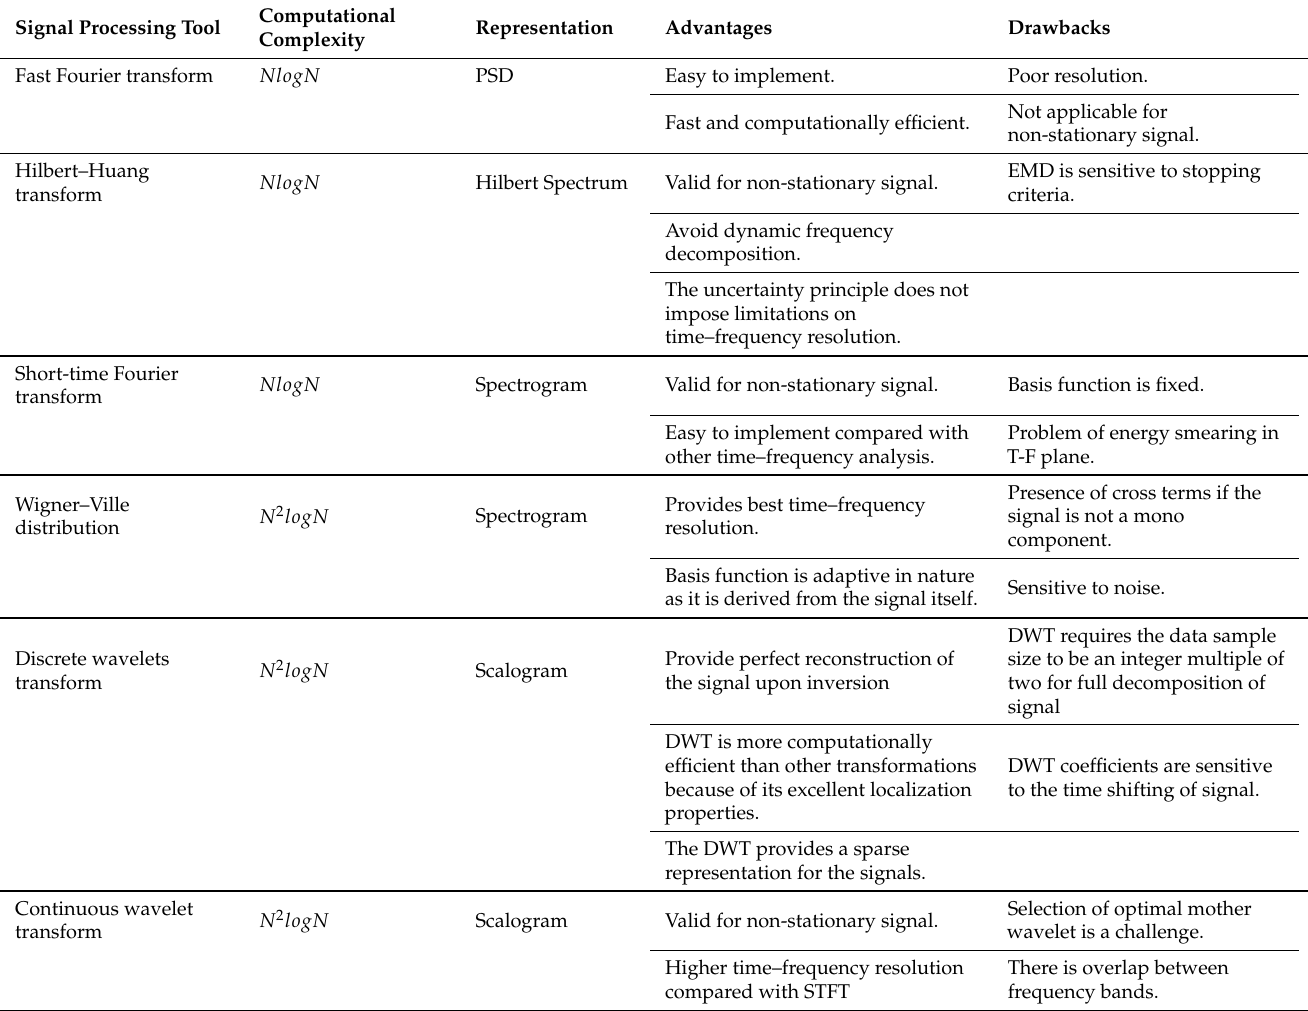
Table 1. Comparison of signal processing methods related to BRB detection